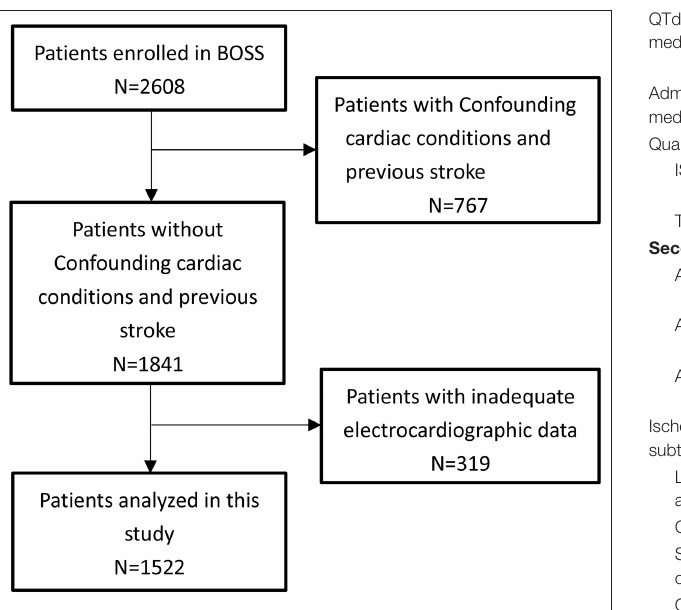
FIGURE 1 | Flowchart of the study.